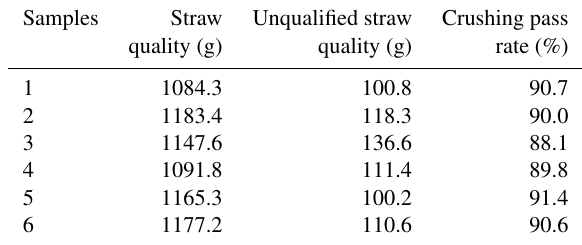
Table 3. Qualification rate of straw